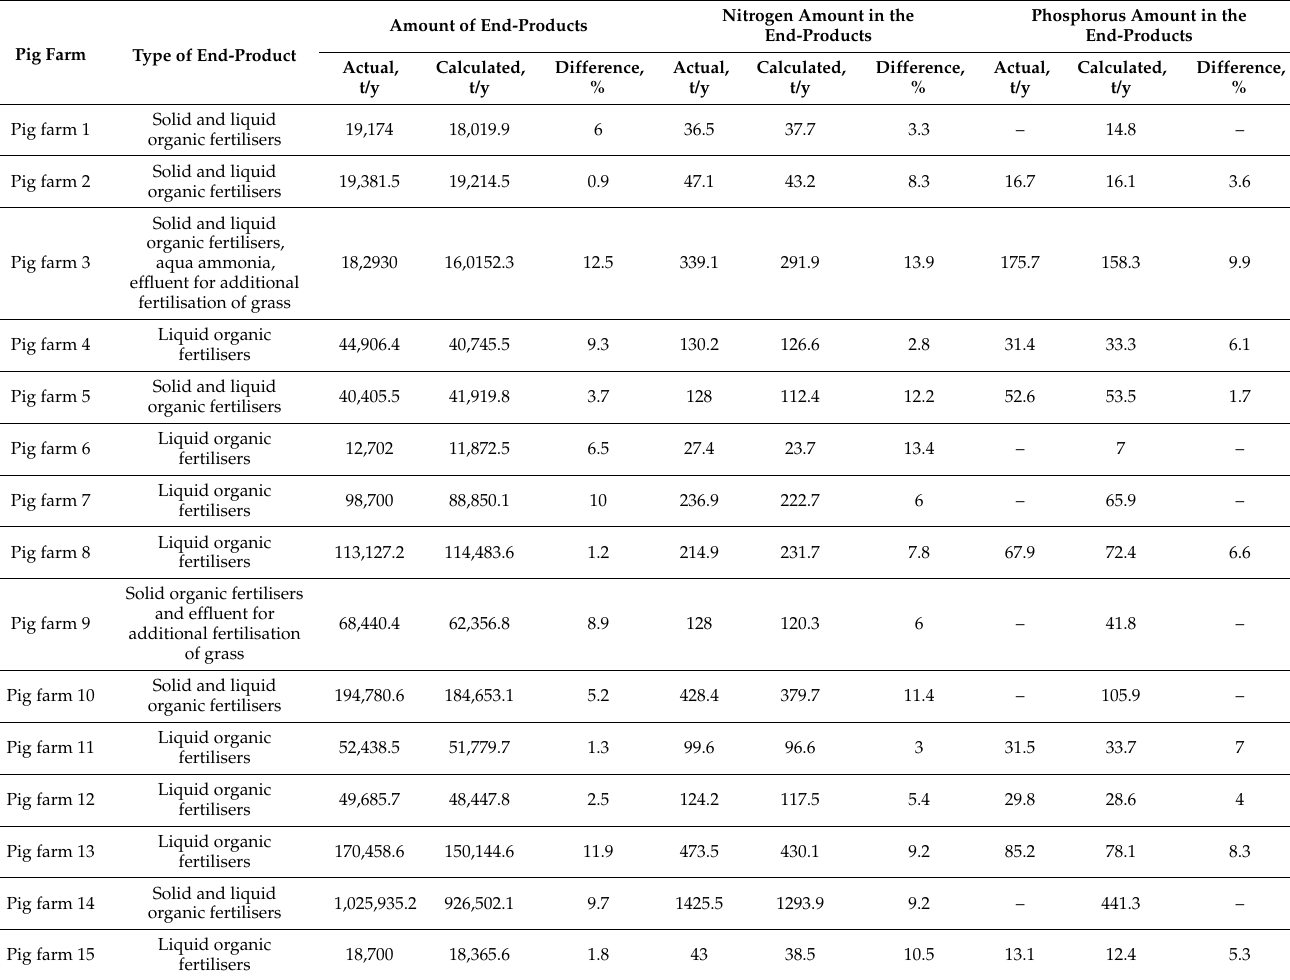
Table 6. Estimated and actual indicators of final products based on pig